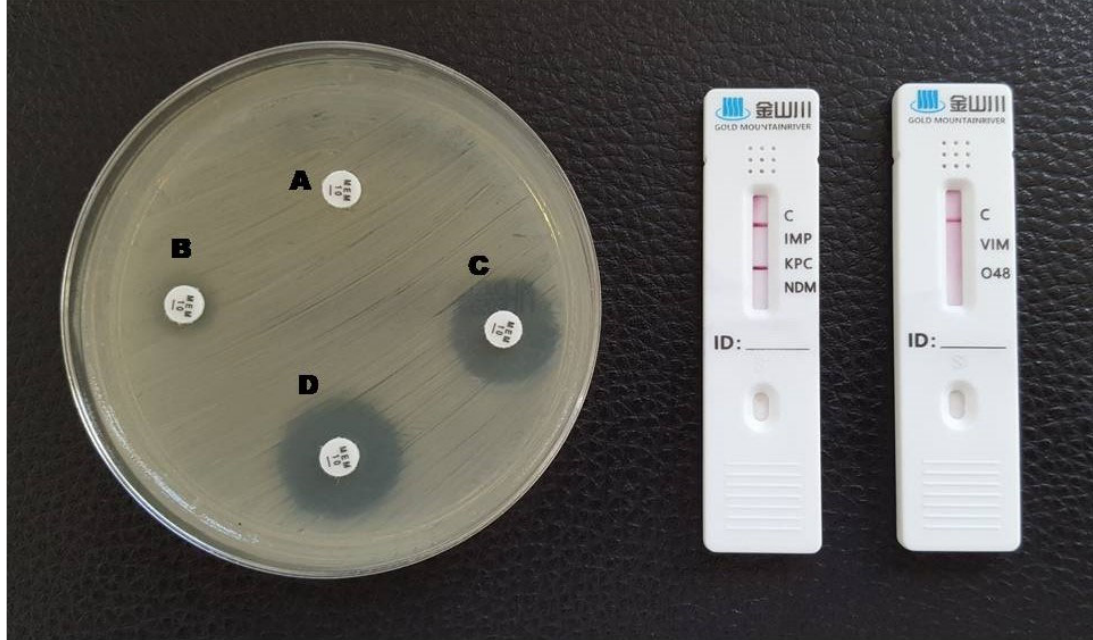
Figure 1. Phenotypic and lateral flow assay results for a KPC ‐ producing K. pneumoniae . A: meropenem disc without inhibitors; B: meropenem + EDTA; C: meropenem + phenylboronic acid; D: meropenem + EDTA + phenylboronic acid. A red line in the KPC test area is visible in the LFA.